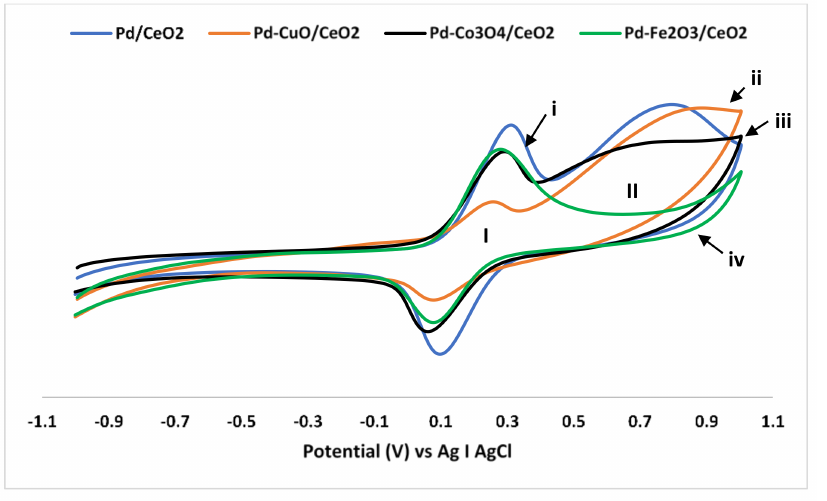
Figure 5. The CV response of GCE ( i ) Pd/CeO 2 , ( ii ) Pd-CuO/CeO 2 , ( iii ) Pd-Co 3 O 4 /CeO 2 , and ( iv ) Pd-Fe 2 O 3 /CeO 2 in the presence of 1M KOH in 1M glycerol. Scan rate = 100 mV/s. Process I is